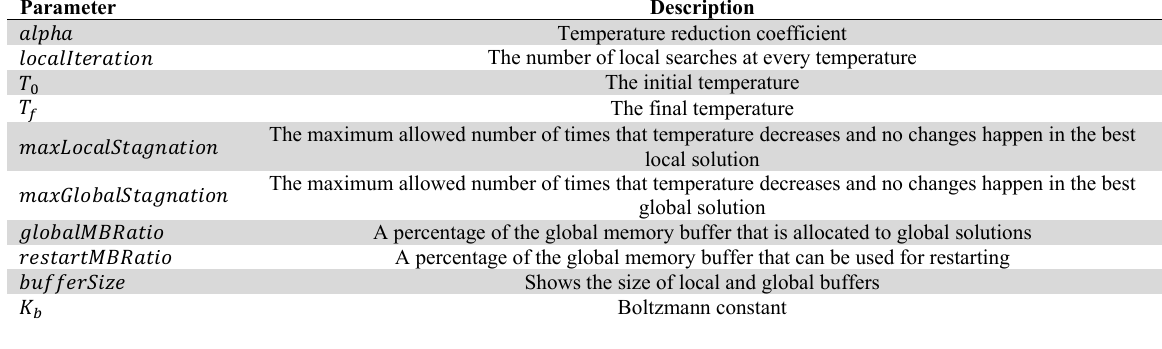
The variables of the proposed algorithm Variable Description